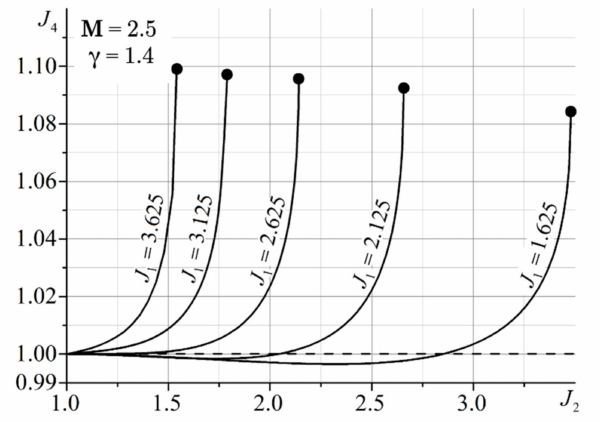
Figure 17. Dependence of the intensity of reflected discontinuity J 4 on the intensity of the first J 1 and second J 2 overtaking shocks for M = 2.5.